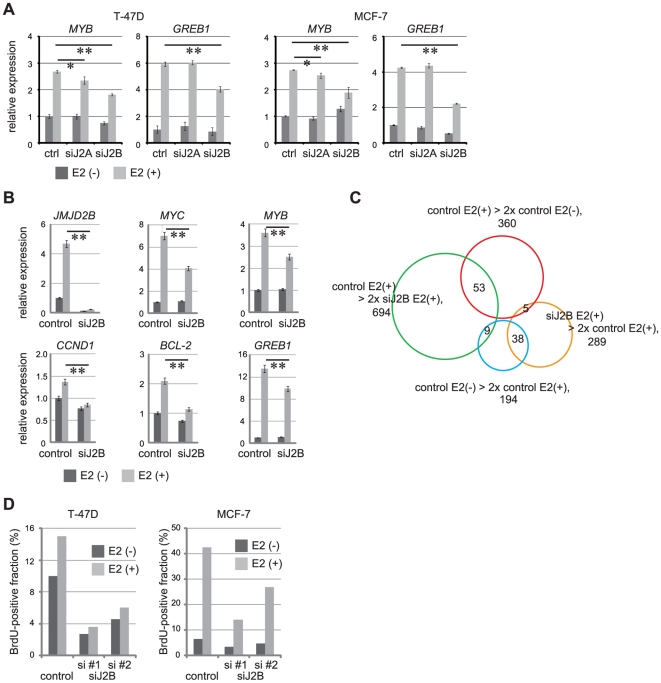
JMJD2B mediates induction of ER target genes and estrogen-dependent proliferation of breast cancer cells.(A) Effect of JMJD2A or JMJD2B knockdown on induction of ER target genes. T-47D cells and MCF-7 cells were transfected with either control siRNA, JMJD2A siRNA or JMJD2B siRNA, cultured in steroid-free medium for 72 hr, and stimulated with or without E2 for 4 hr. (B) JMJD2B knockdown impairs ER target gene induction. T-47D cells were transfected with either control siRNA or JMJD2B siRNA, cultured in steroid-free medium for 72 hr, and stimulated with or without E2 for 4 hr. (A and B) mRNA levels of JMJD2B or the indicated ER target genes were measured by real-time RT-PCR. Results represent mRNA levels normalized to the level of ACTB mRNA (mean ± s.d. of triplicates). **p<0.01. (C) Venn diagram representation of the differentially expressed genes. The area of each circle reflects the number of genes contained in the respective categories. The heat map is in Figure S4C. The lists of the genes are in Tables S2, S3, S4, S5. (D) JMJD2B knockdown impairs cellular response to estrogen. T-47D cells or MCF-7 cells transfected with control siRNA or JMJD2B siRNA were cultured in steroid-free medium for 48 hr, stimulated for 24 hr with E2, labeled for 1 hr with BrdU, and stained with anti-BrdU antibody and 7-AAD. The fraction of BrdU-positive cells was determined by flow cytometry. A representative result from three independent experiments.